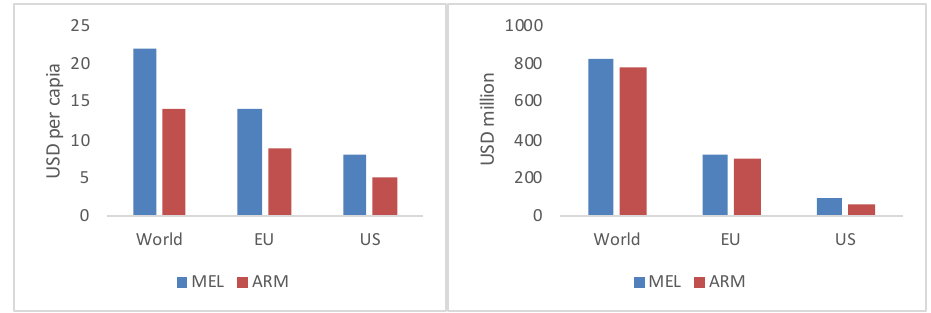
Figure 4. Change in welfare [Equivalent variant per capita in constant USD] and export volumes [Mil- lion constant USD] under the under Melitz and Armington specification.